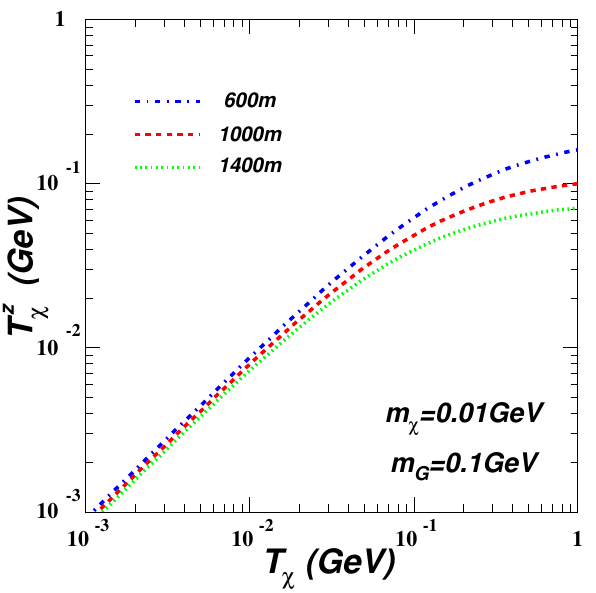
Figure 3 . The kinetic energy T z initial energy of CRDM T χ .